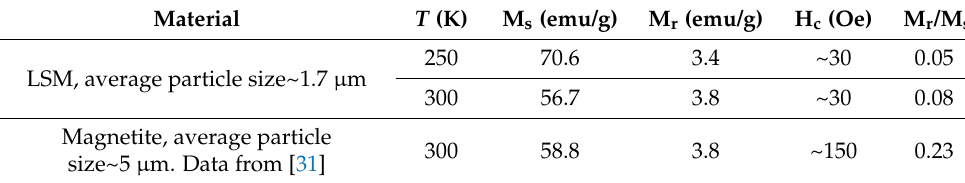
Figure 8. Magnetization as a function of the applied magnetic field of LSM particles at 250 K (blue), 300 K (green), 350 K (red)-accuracy 10 − 8 emu. The inset exhibits details of low fields. Table 3. Magnetic parameters of LSM particles (accuracy 10 − 8